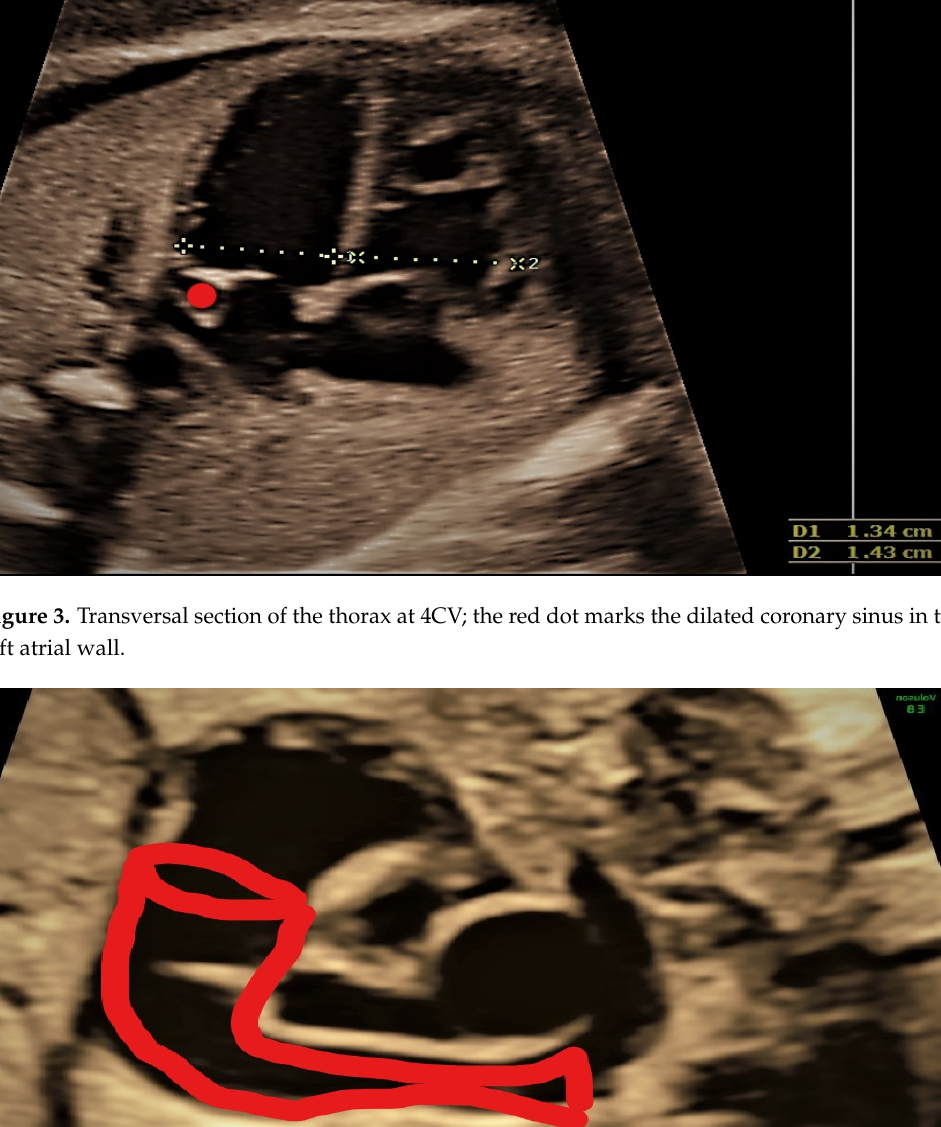
Figure 1. Transversal section at the TTVV—four vessels can be seen—from left to right, persistent left superior vena cava (PLSVC), main pulmonary artery (MPA), aortic arch (AoA) and right supe- rior vena cava (SVC).